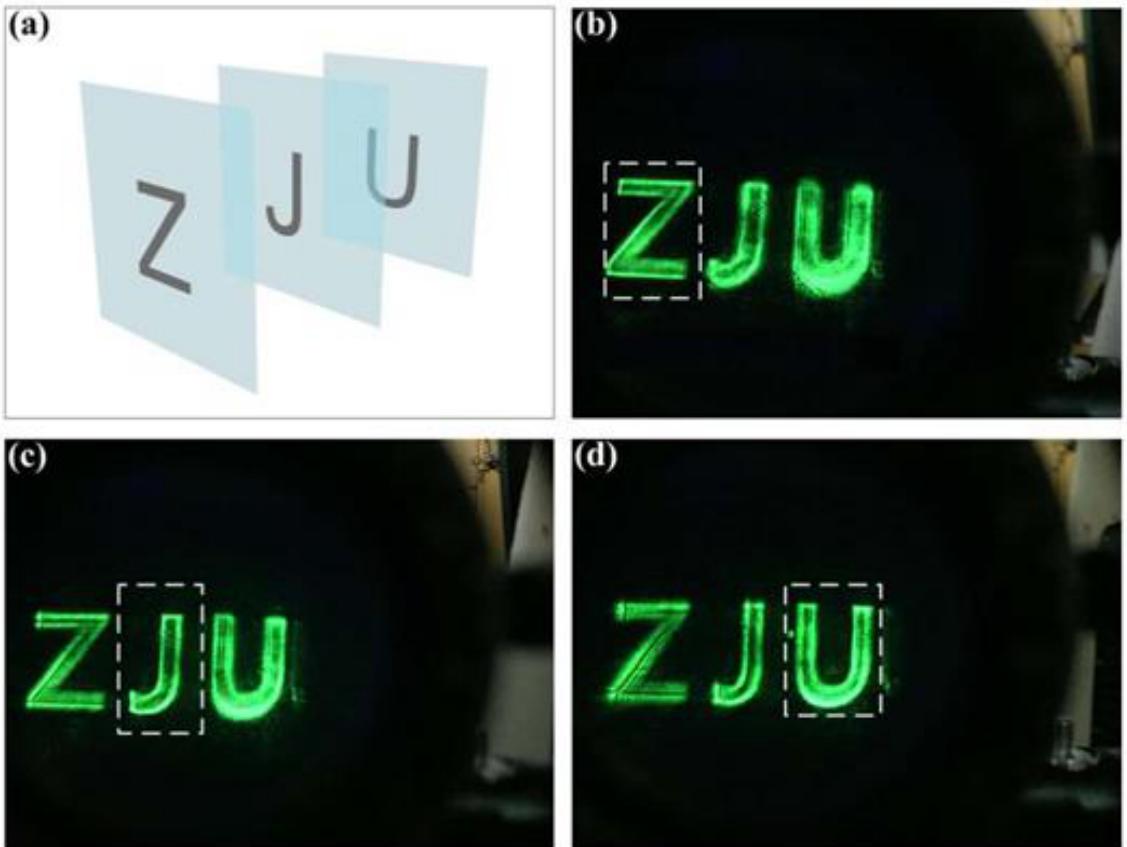
Figure 7. 3D near-eye display of ZJU characters. ( a ) The layered model ZJU. ( b – d ) The reconstructed images focused at Z, J, and U, respectively.